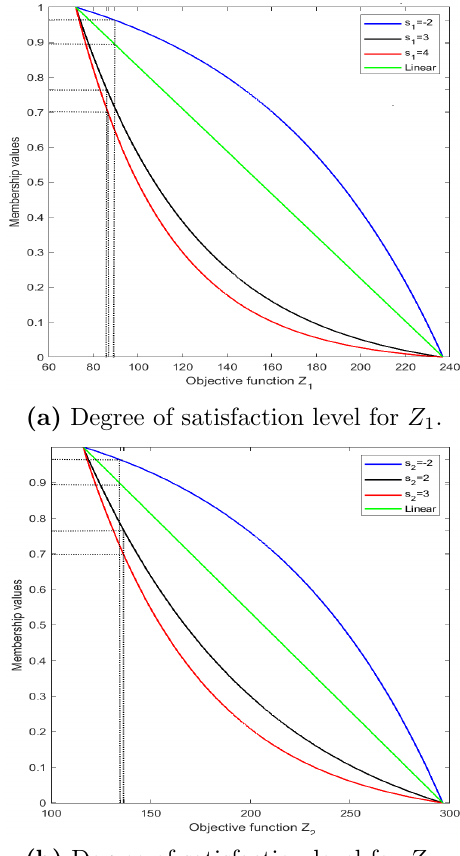
Figure 1. Graphical representation of solutions for EV Model-5 with